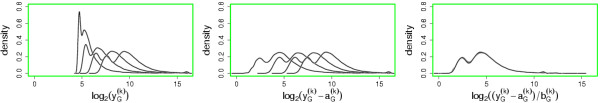
Densities of the logarithm of the raw, translated, and calibrate signals. The affine normalization method makes the signal densities much more similar. Left: Density plots of the logarithm of the raw signals for each of the fours scans. Mid: Bias corrected signals. Right: Bias and scale calibrated signals. Data and colors are the same as in Figure 1.